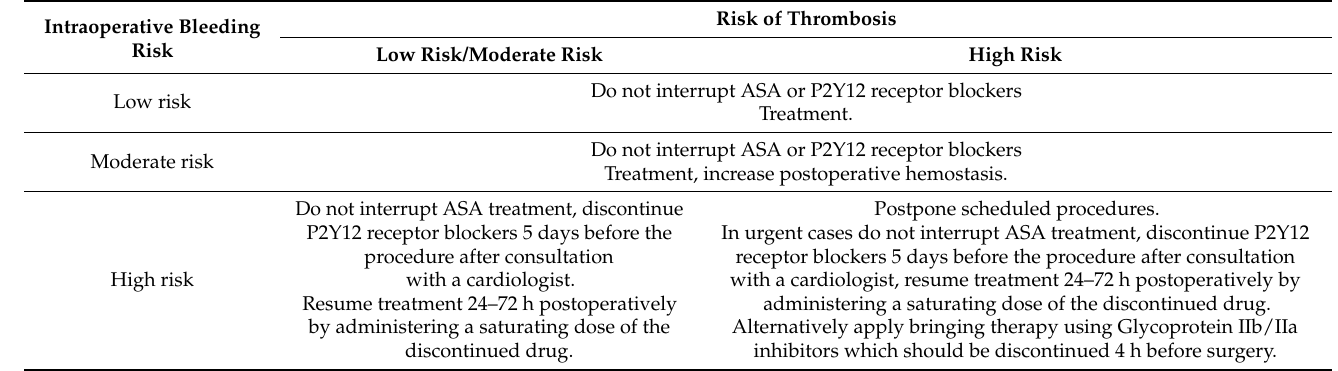
Table 2. The table shows the management regimen for patients receiving double anticoagulant therapy. Intraoperative Bleeding